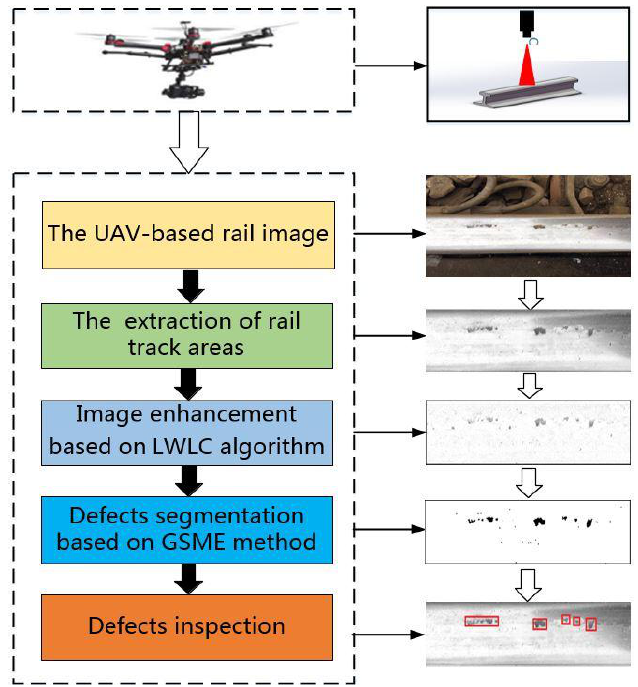
Figure 2. Flow diagram of the inspection method for the rail surface defects based on the UAV images.